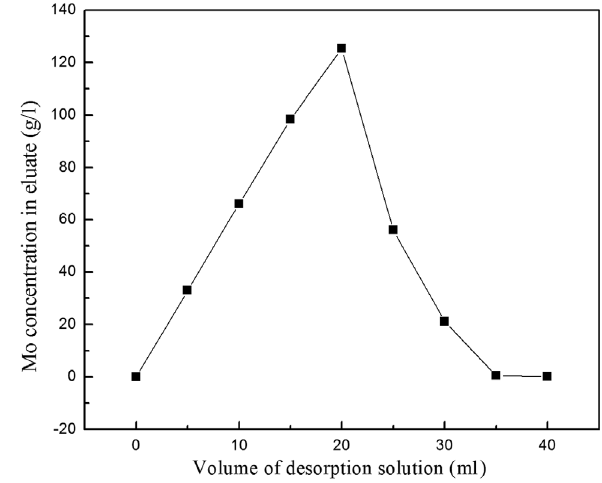
Figure 2: Effect of pH value on static tests for adsorption capacity of molybdenum (Mo).